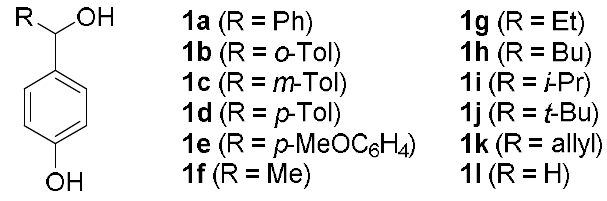
Figure 2. Starting p -hydroxybenzyl alcohols 1 used in this work.